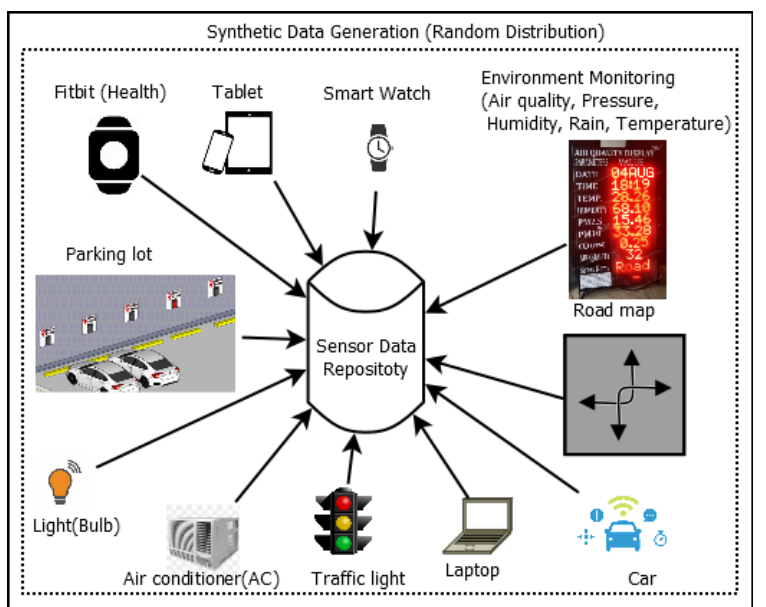
Figure 1. Input sensors (IoT